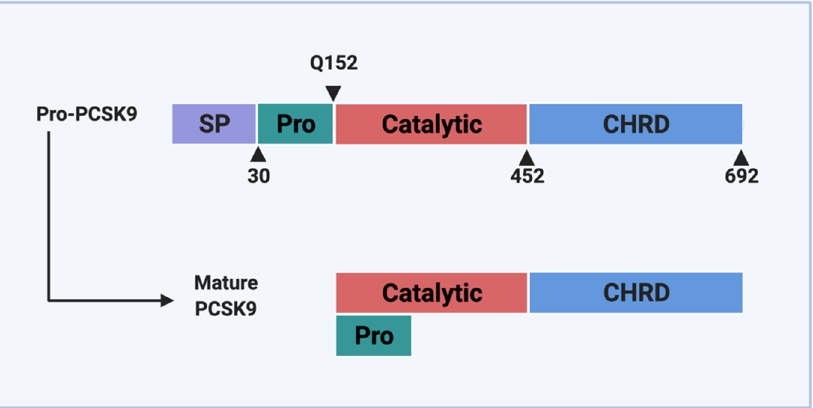
Figure 1. Domain structure of PCSK9. PCSK9 protein consists of a signal peptide (SP) that serves as a guide into the ER, a pro-domain (Pro) that undergoes self-cleavage during maturation, a catalytic domain, and a Cys-His-rich domain (CHRD) located at the C-terminus. Following the process of autocatalytic cleavage, the pro-domain remains associated with the catalytic domain and prevents further catalytic activity.